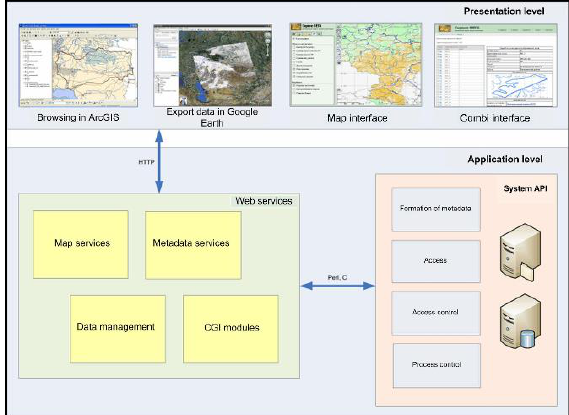
Figure 1. GEOSMIS architecture.